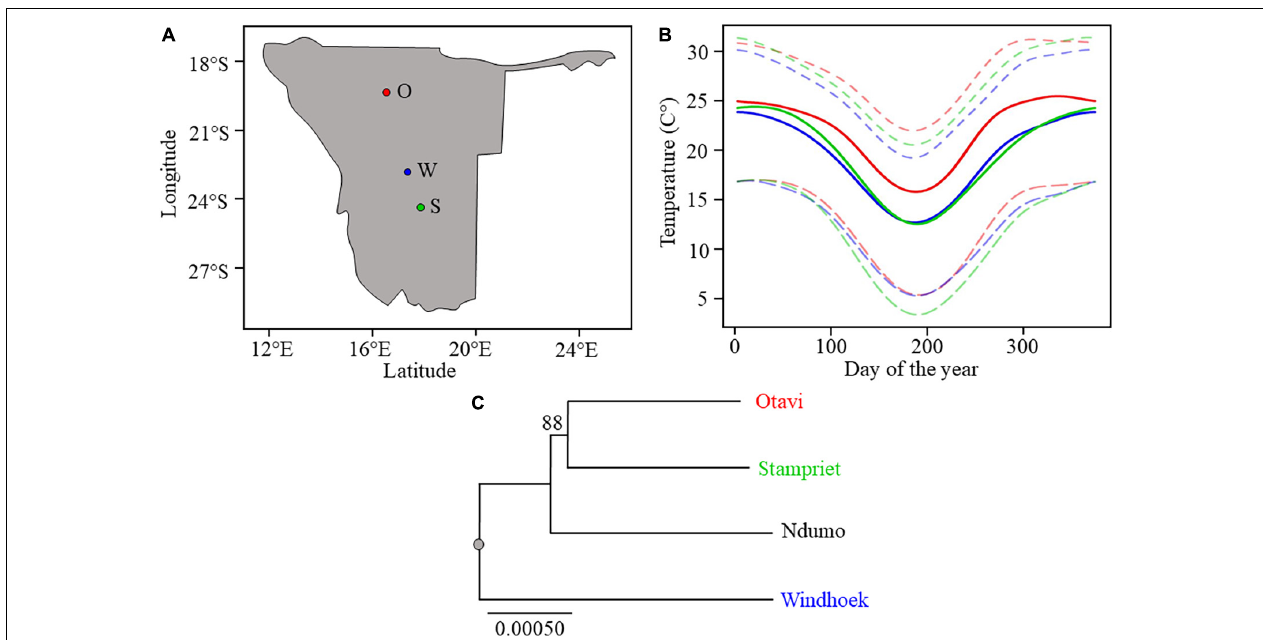
FIGURE 1 | (A) Map of Namibia with sampling sites depicted with circles. From North to South: Otavi (O), Windhoek (W), and Stampriet (S). (B) Average maximum, mean, and minimum temperatures for the three sampled sites along the temperature gradient: Otavi (in red) is the hottest site, then Stampriet (in green) and Windhoek (in blue). The temperature plots are based on daily mean temperature from 30 years (1961–1990) climate data (Grieser et al., 2006). (C) Phylogenetic tree based on a subset of coding positions showing S. dumicola population phylogeny of sampled populations. Bootstrap values above 60% are shown. The scale bar indicates the proportion of sites changing along the